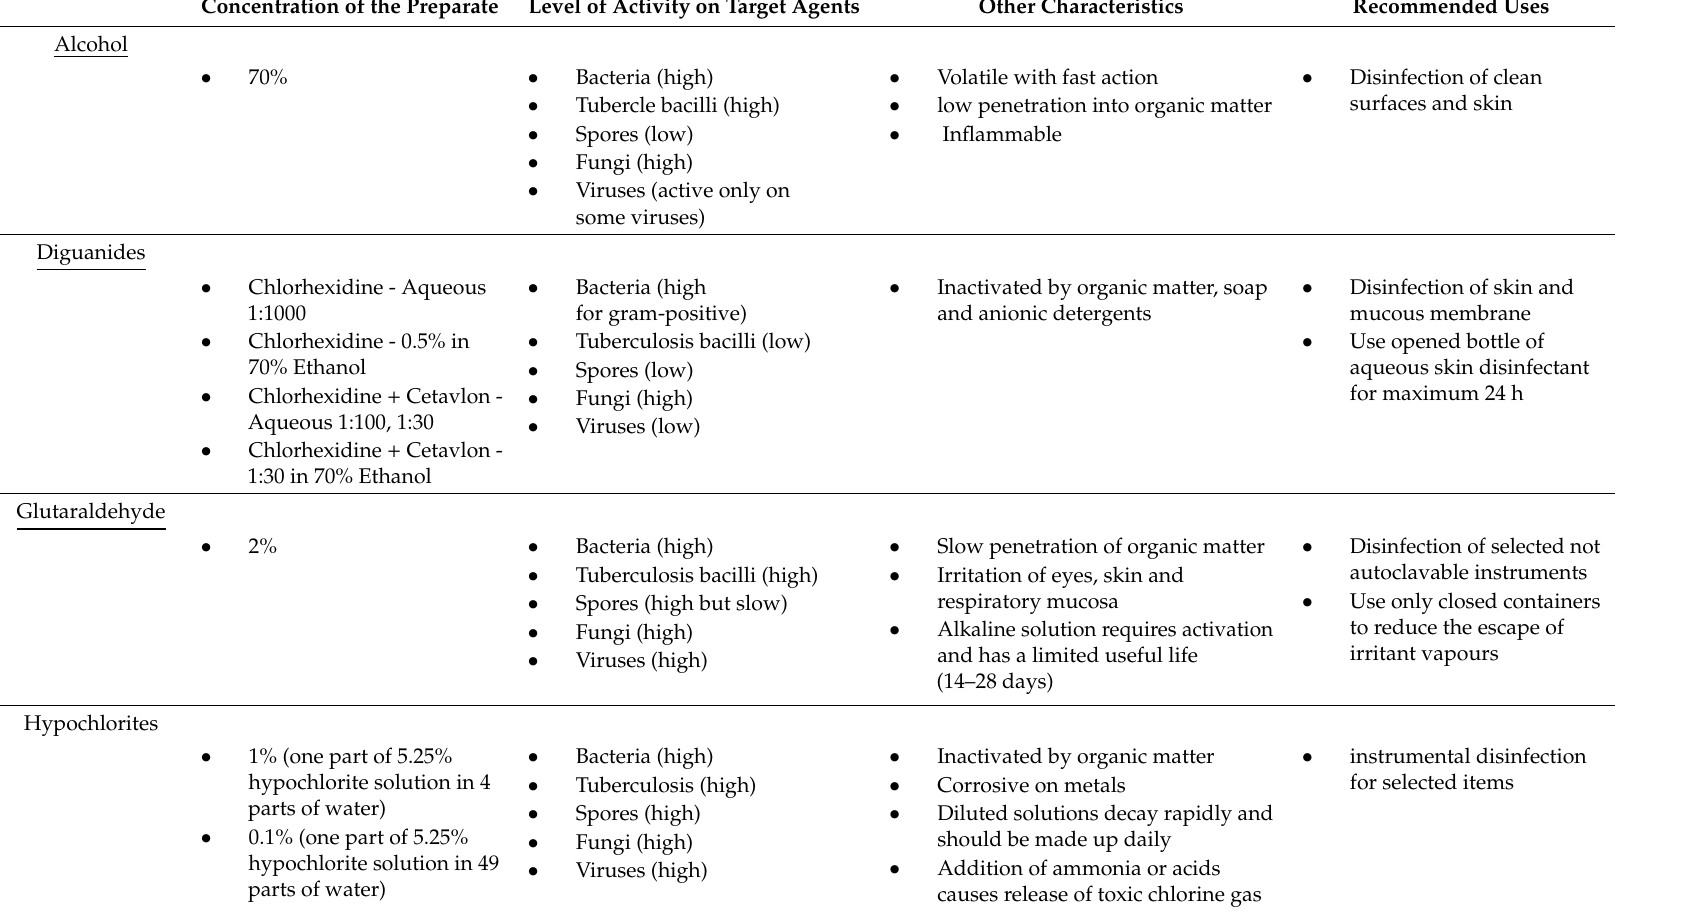
Table 4. commonly used chemical